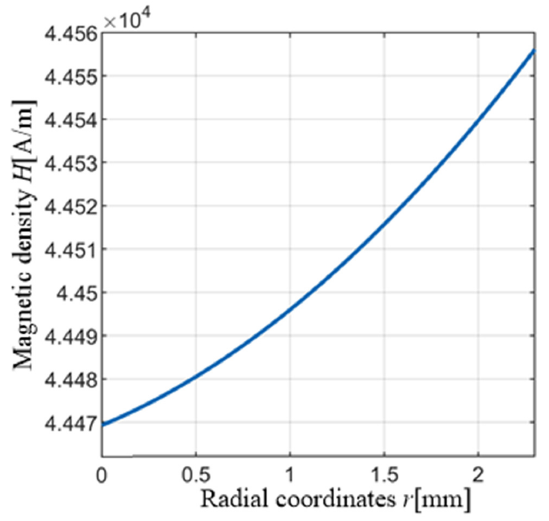
Figure 8. Radial magnetic field distribution of the cylinder section at 50% of the total length of the GMM cylinder.